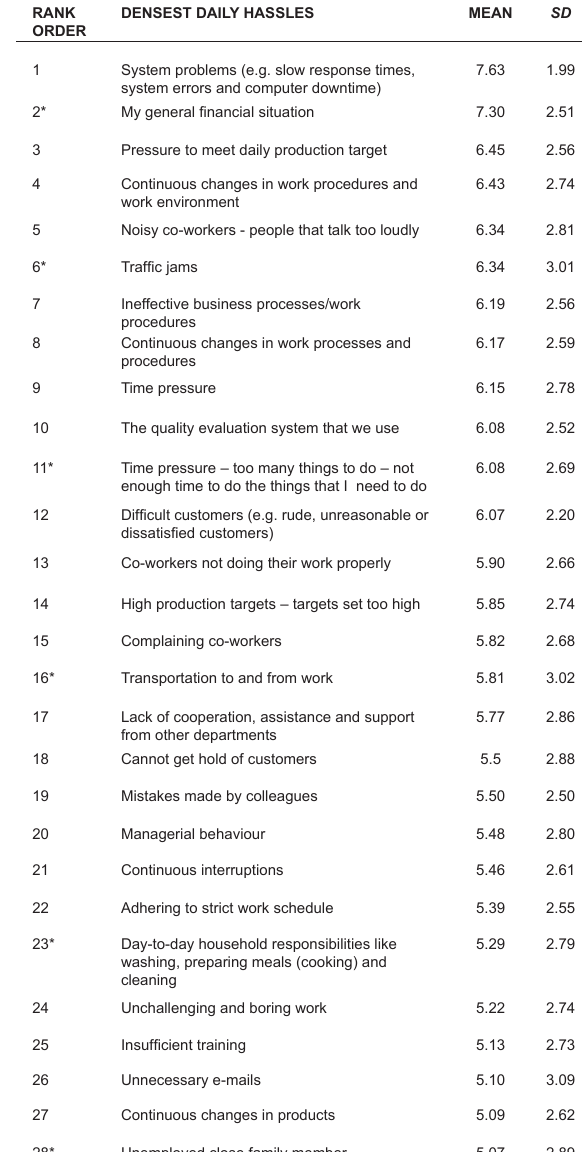
Table 1 Characteristics of participants ( N = 394)